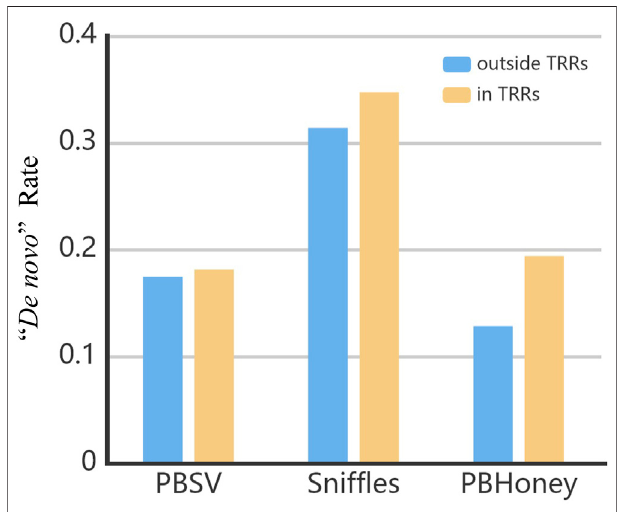
FIGURE 6 | The “ de novo ” rate in the callsets of three pipelines in and outside TRRs.